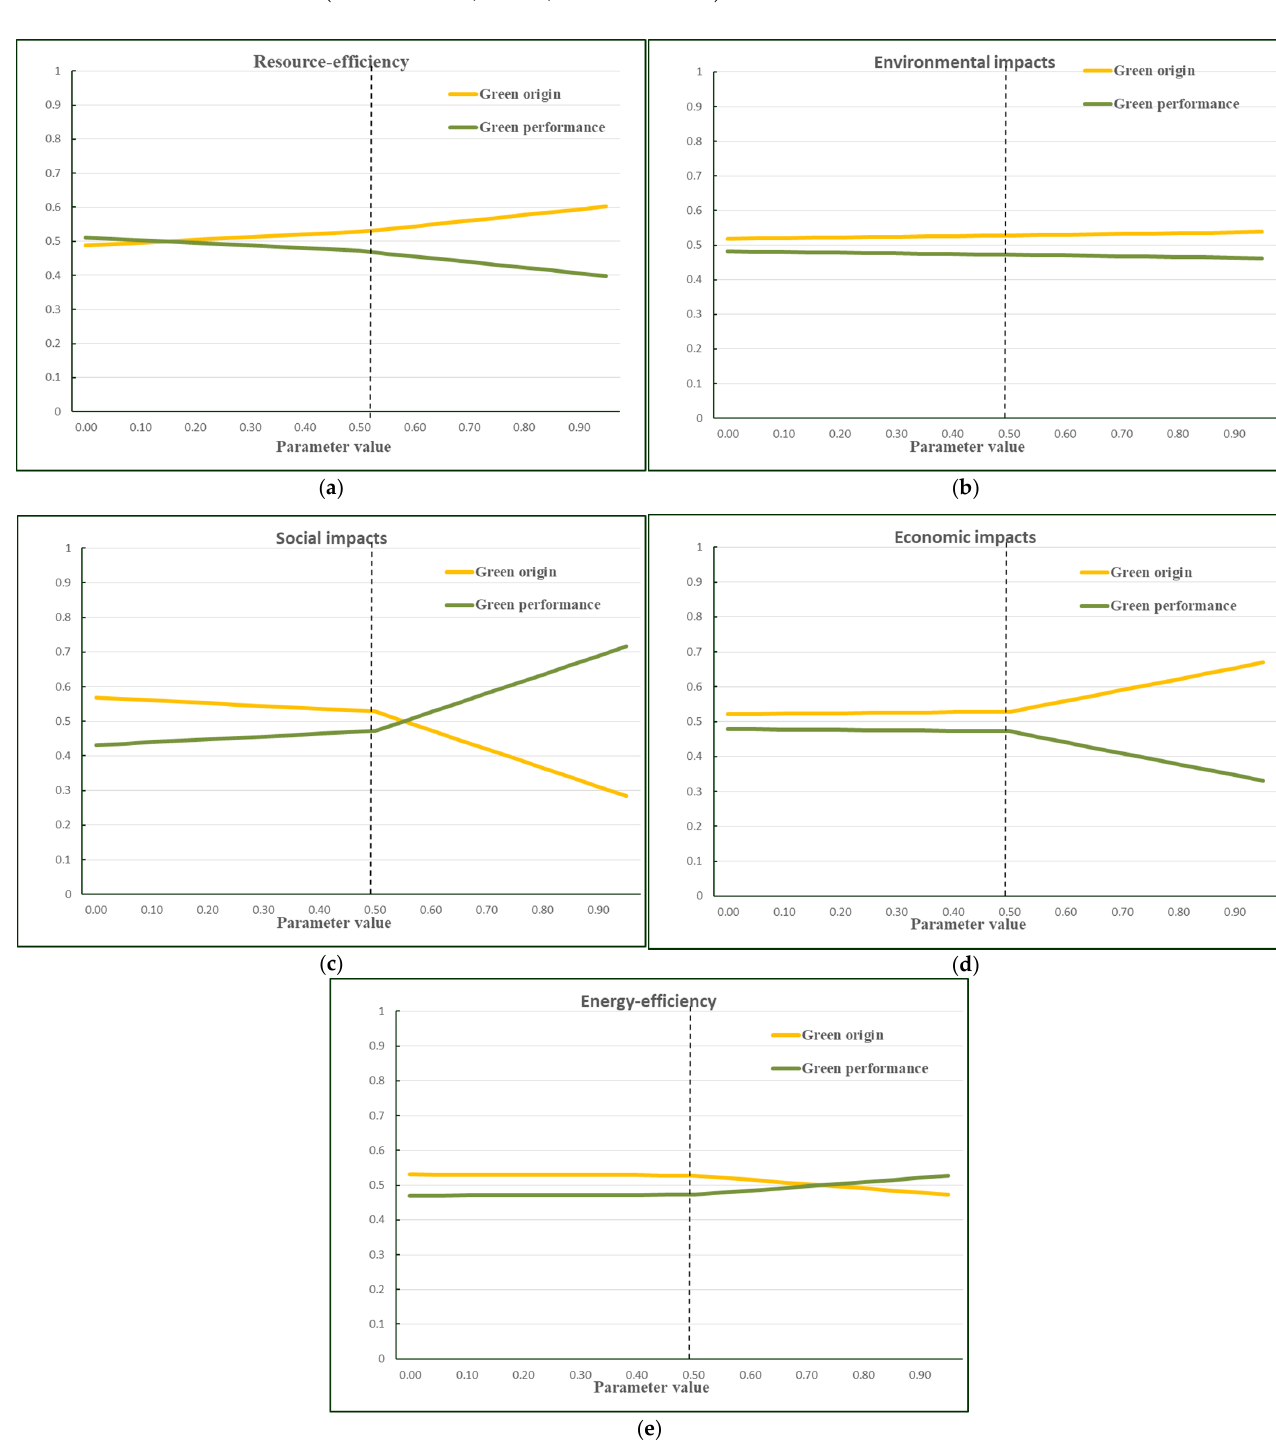
Figure 6. Sensitivity analysis for ( a ) Resource efficiency, ( b ) Environmental impacts, ( c ) Social impacts, ( d ) Economic impacts, and ( e ) Energy efficiency.